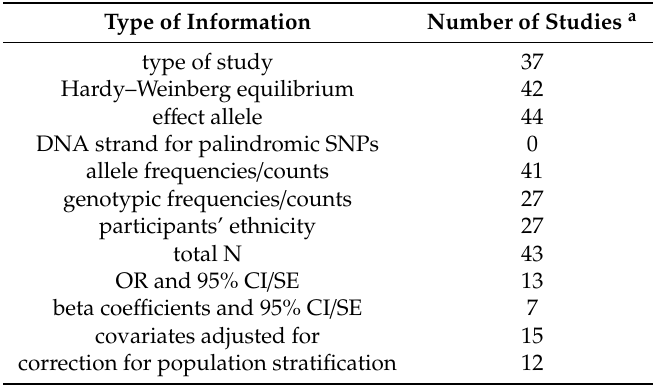
Table 2. Useful information to be reported from local studies. Type of